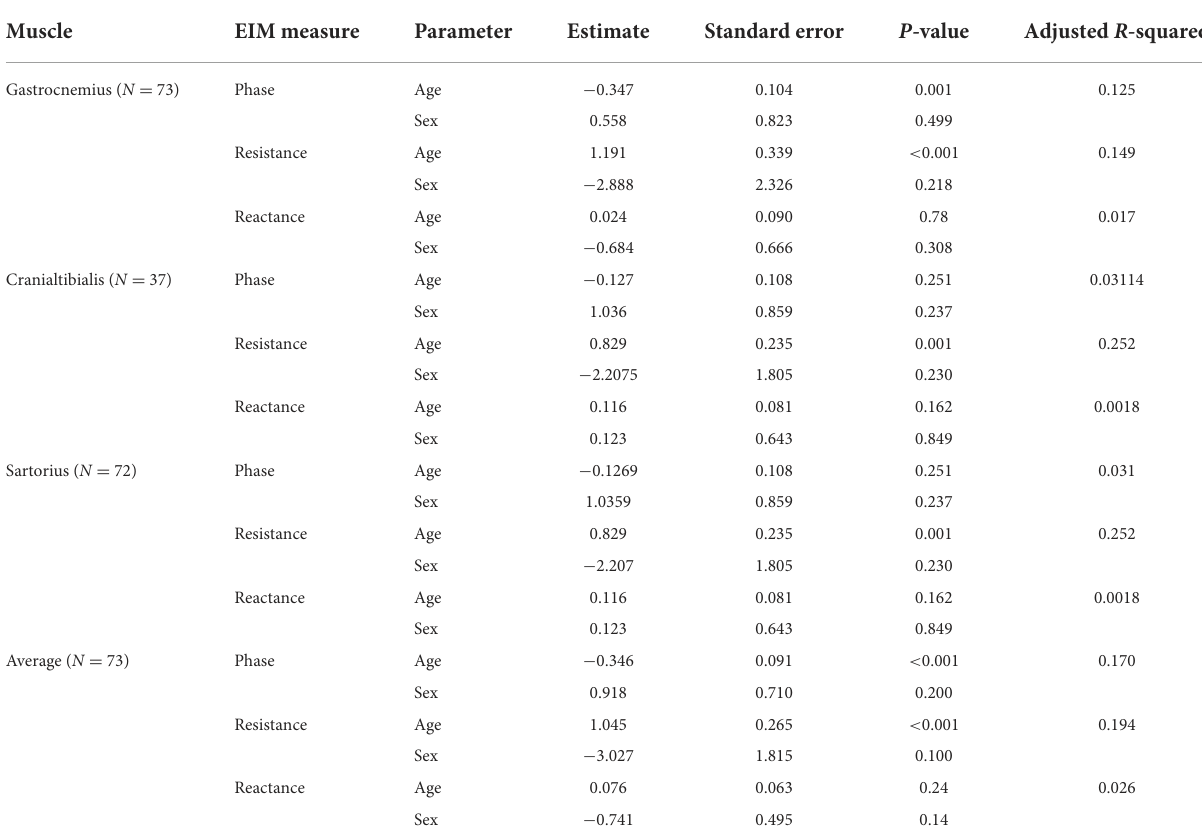
TABLE 3 EIM parameter relationship to age and sex via multivariate regression, revealing significant relationships with age for some parameters, but not for sex. Muscle EIM